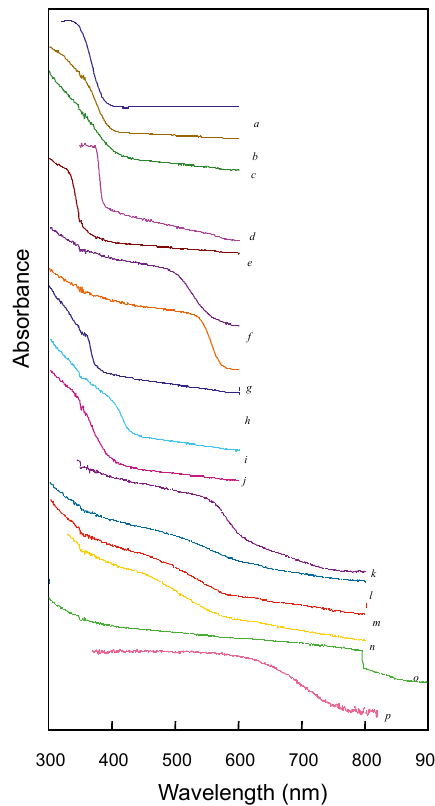
Figure 3. Absorption edges of (a) TiO (d) ZnO, (e) ZnS, (f) CdS, (g) Pb